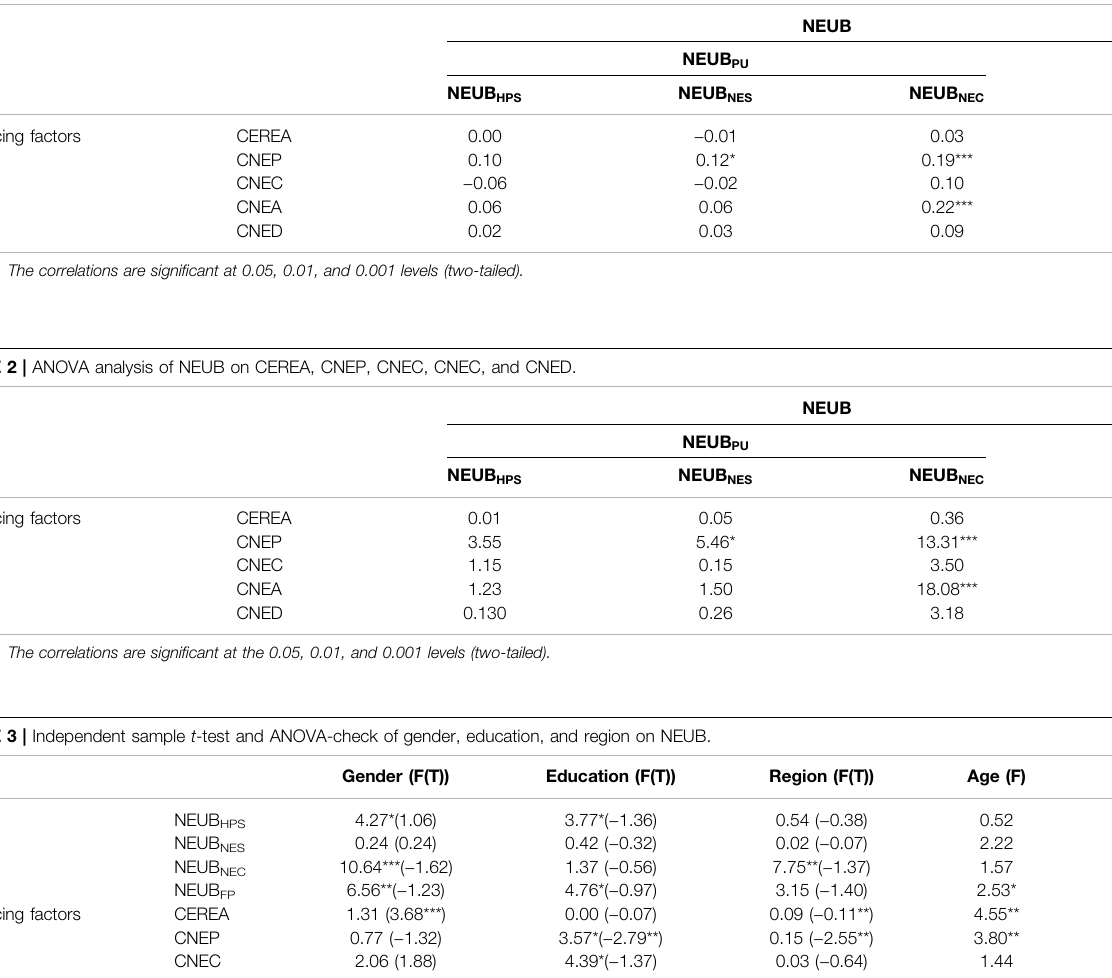
TABLE 1 | Correlation between NEUB and its in fl uencing factors.